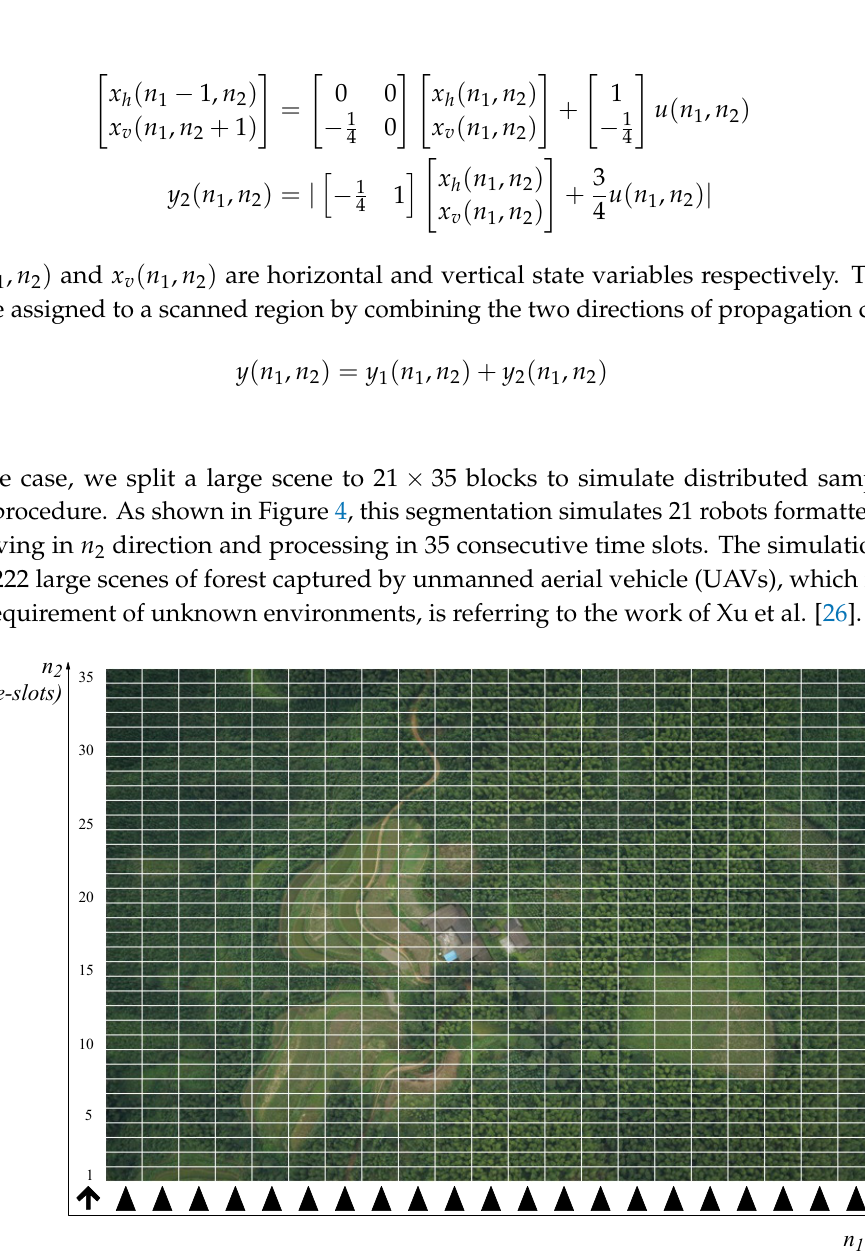
Figure 4. Simulation Configuration of Line Scan